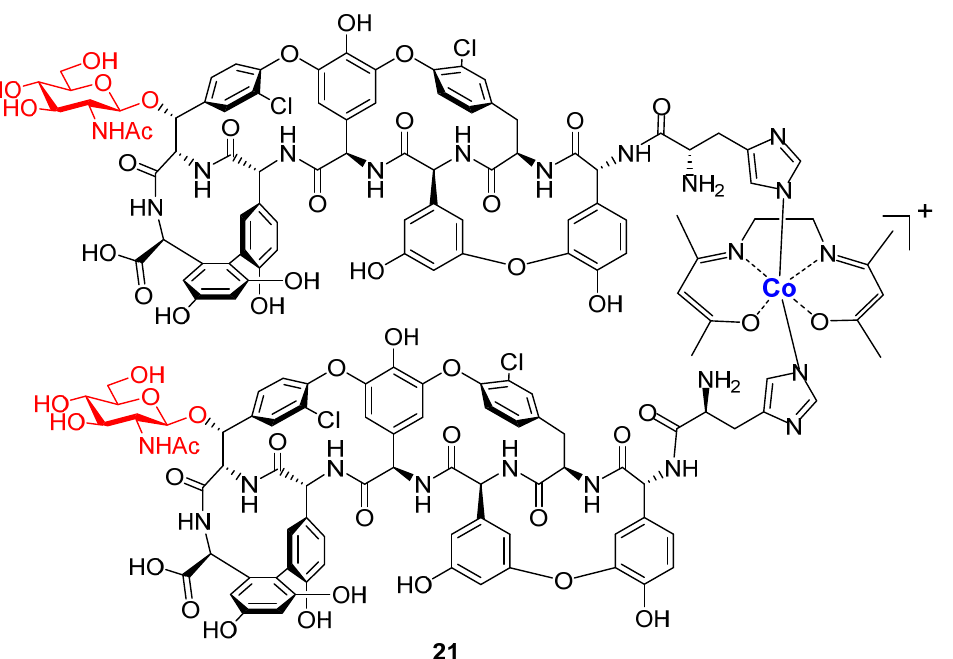
Figure 1. Structure of the Co(III) complex dimer obtained from 3 .